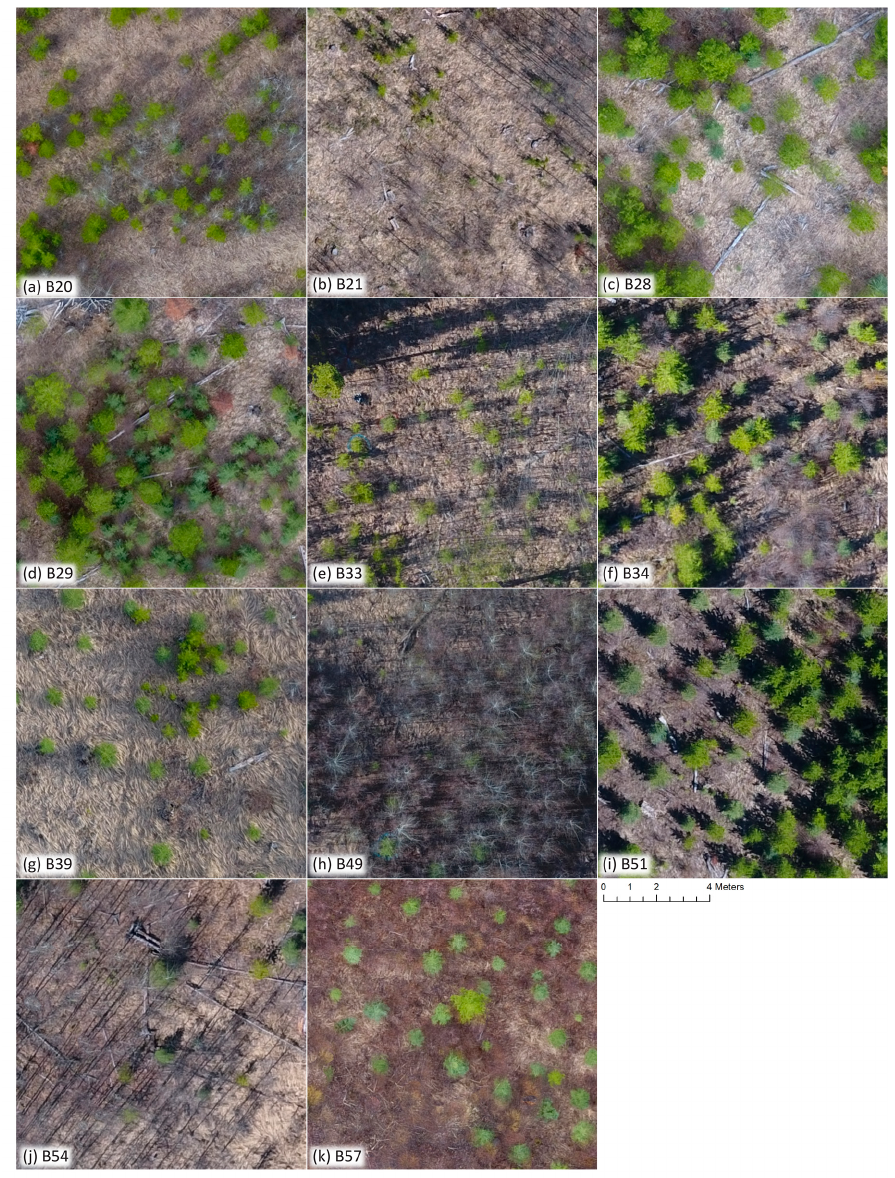
Figure 4. External validation tiles. The 3-digit codes denote which stand the tile was sampled from. See Table 1 for more information regarding these forest stands.